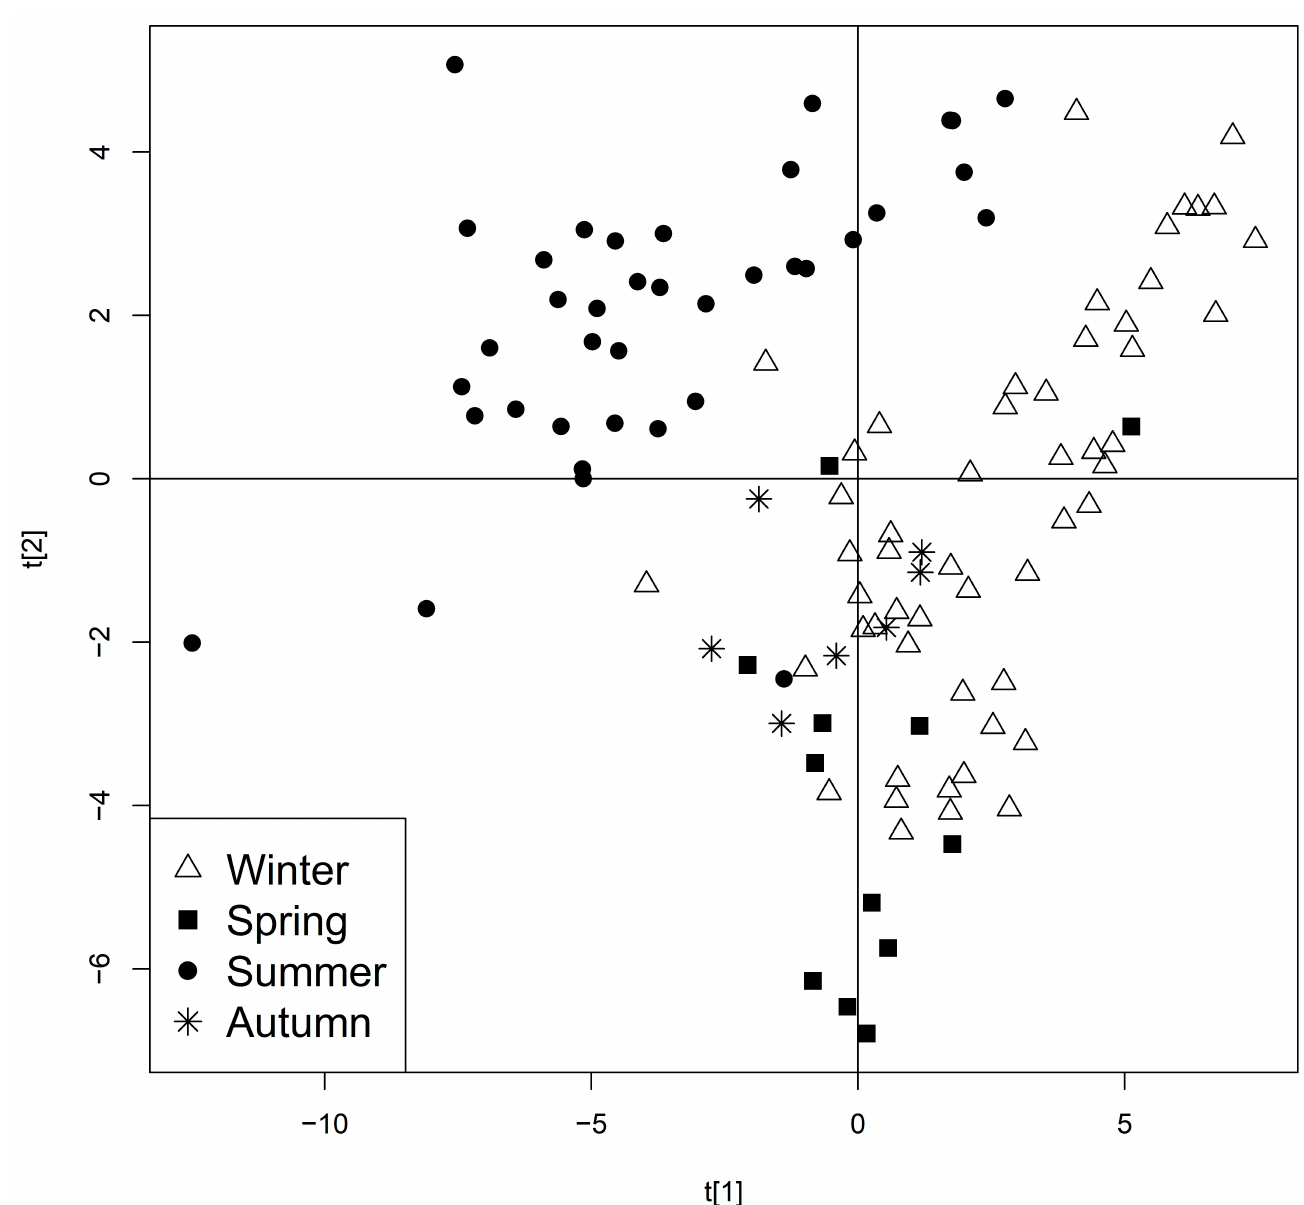
Figure 3. PLS-DA score plot (t2 vs. t1) of 1 H-NMR measurements in Naomi Pachino tomatoes seasonal comparison (Masetti et al., 2014).